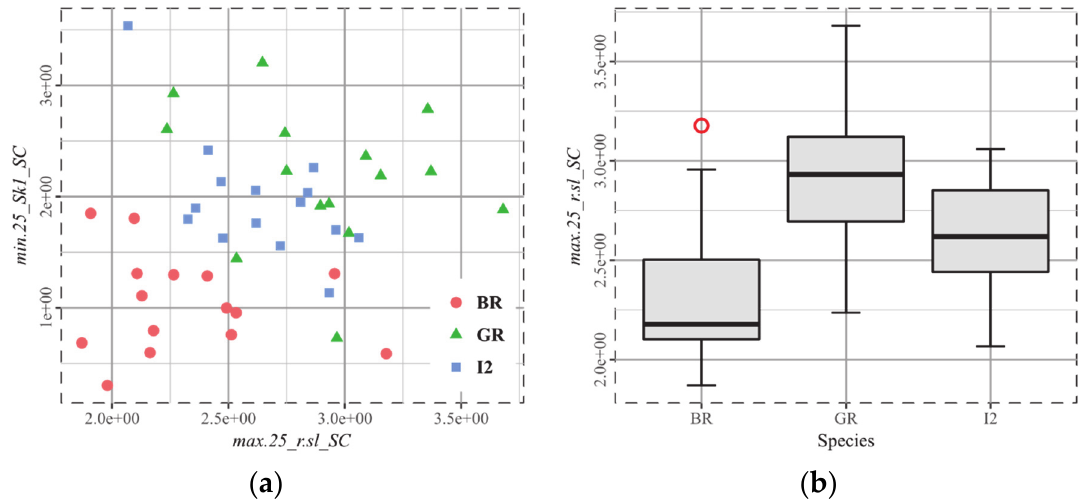
Figure 7. Red deer, most discriminating parameters. ( a ) The anisotropy parameter r.sl together with the topology parameter Sk1 are able to separate the browsing red deer (BR) from the grazing red deer (GR). Some differences can be seen between groups I1 (Figure 6) and I2; and, ( b ) Here, max.25_r.sl_SC is a browser marker.